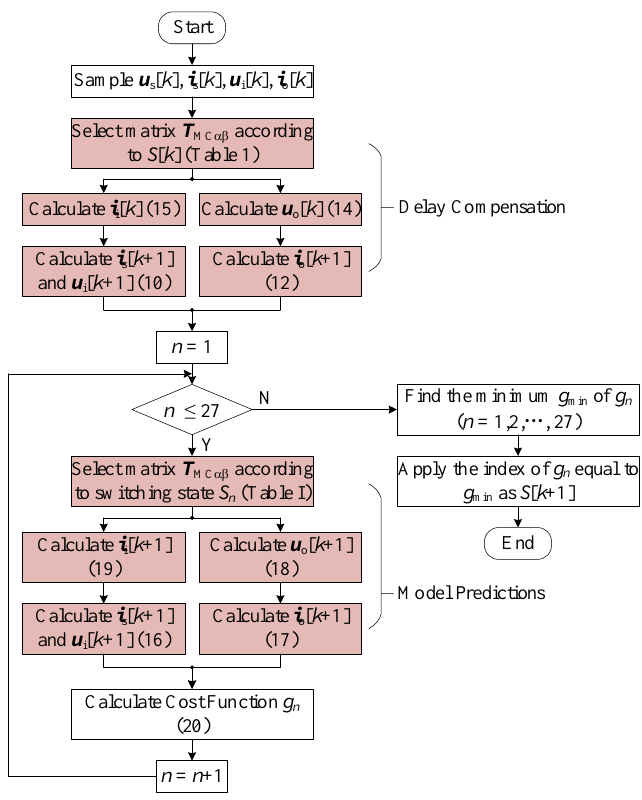
Figure 2. Control flowchart of the conventional MPC scheme.